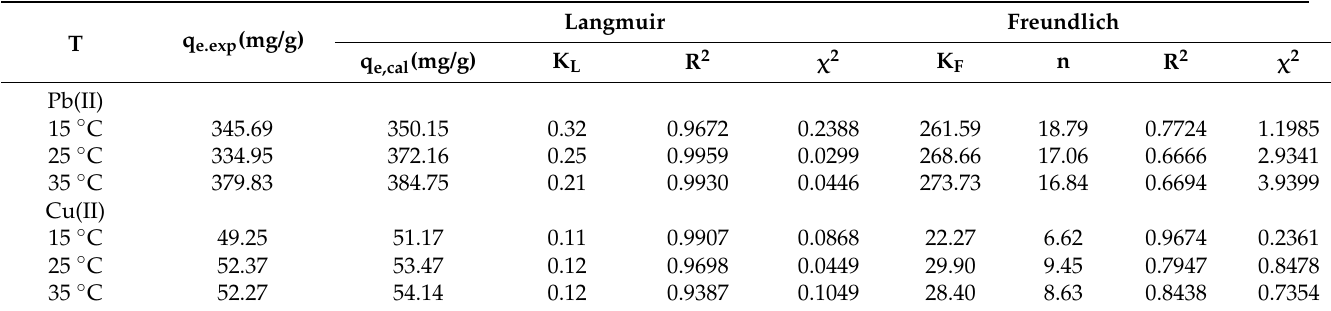
Table 5. Isothermal adsorption fitting data of Pb(II) and Cu(II).